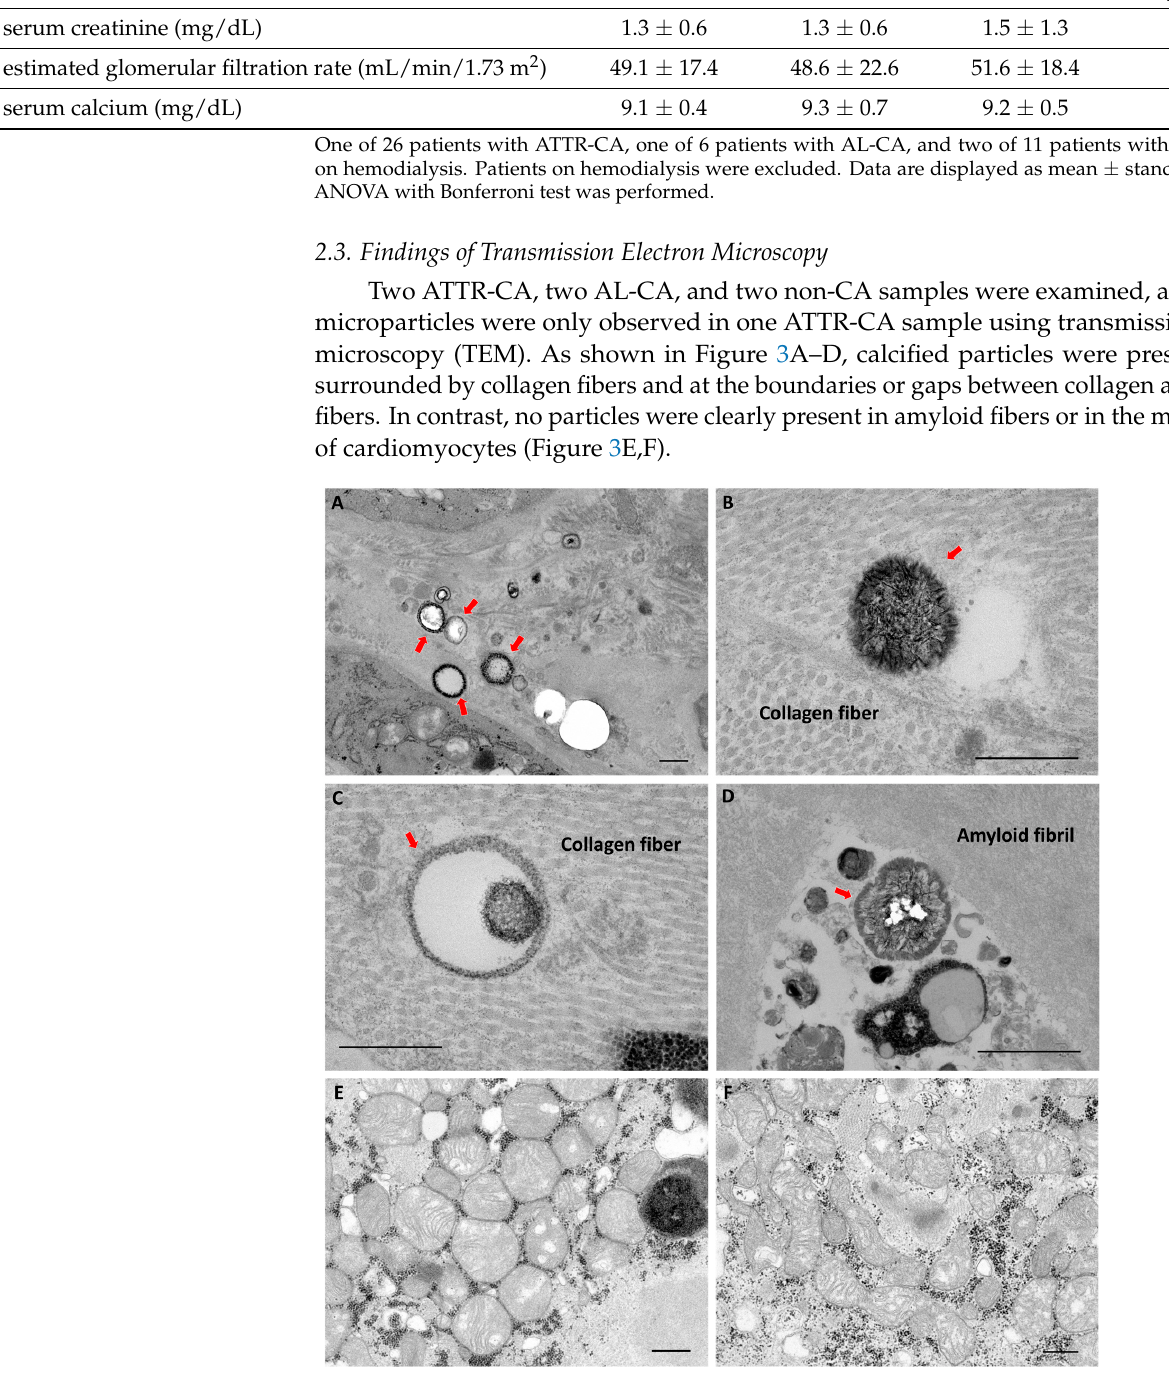
Table 3. Renal function and serum calcium concentration.